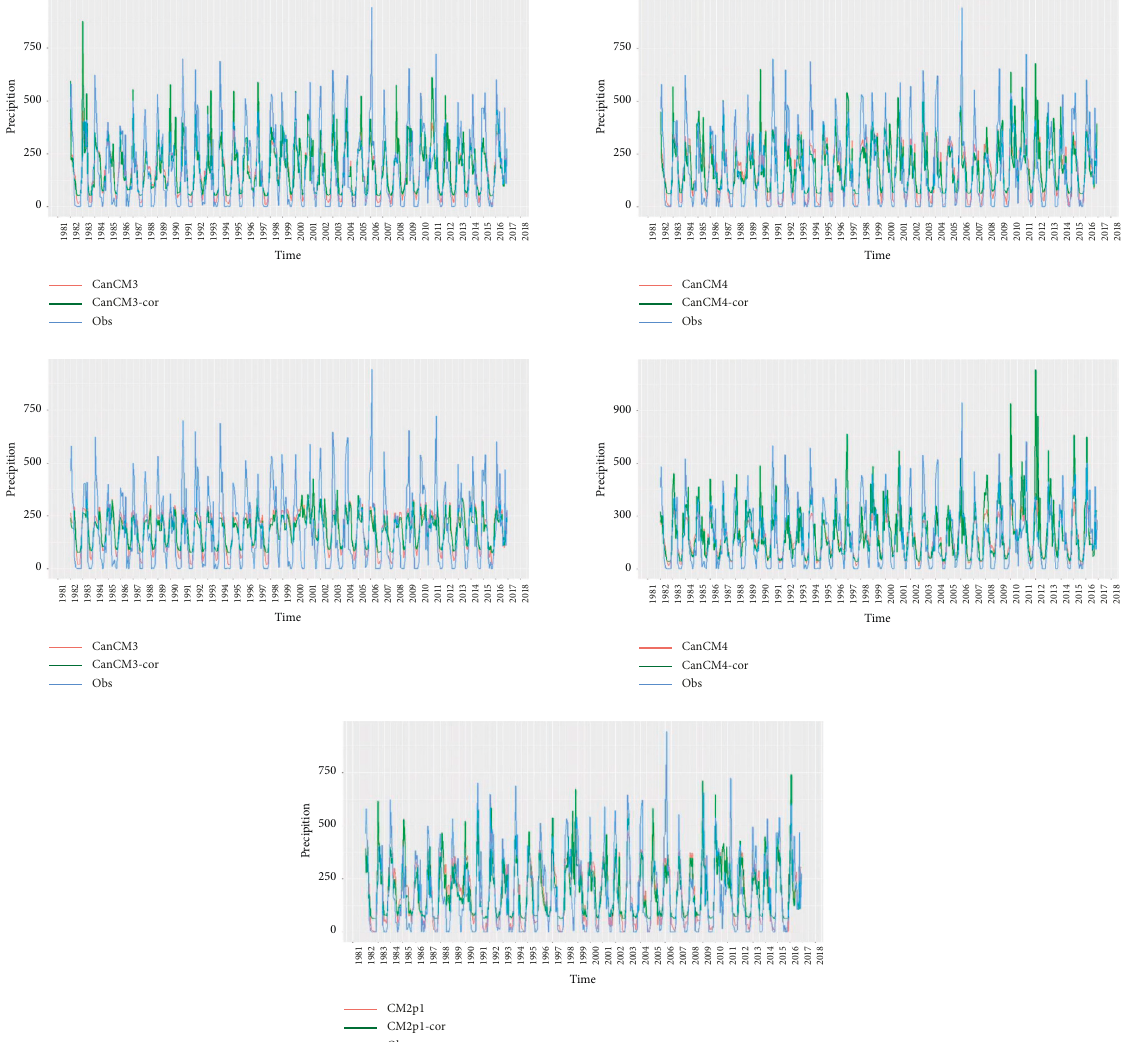
Figure 5: Comparison of the observed rainfall patterns, NMME dataset before and after correction, for each ensemble